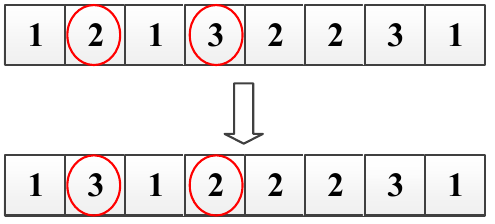
Figure 6. Mutation Operator Based on the Process Coding.